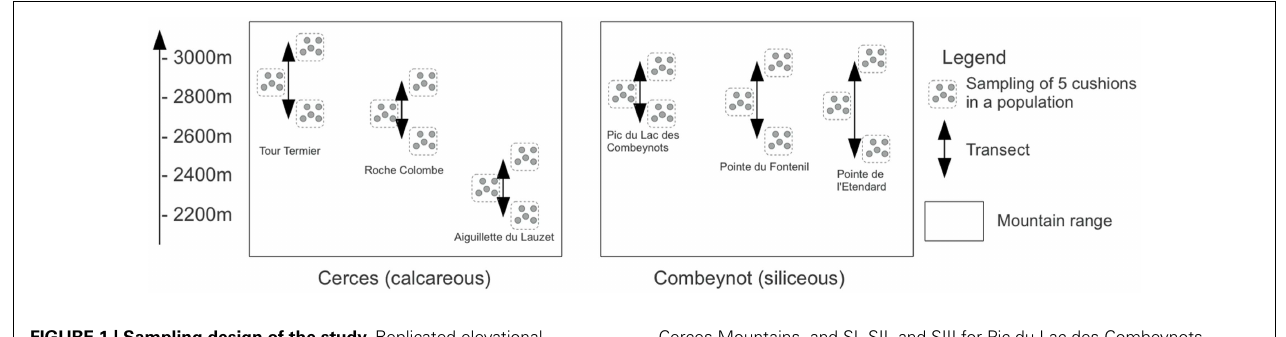
FIGURE 1 | Sampling design of the study. Replicated elevational transects are named CI, CII, and CIII for theTourTermier, Roche Colombe, and Aiguillette du Lauzet, respectively in the calcareous